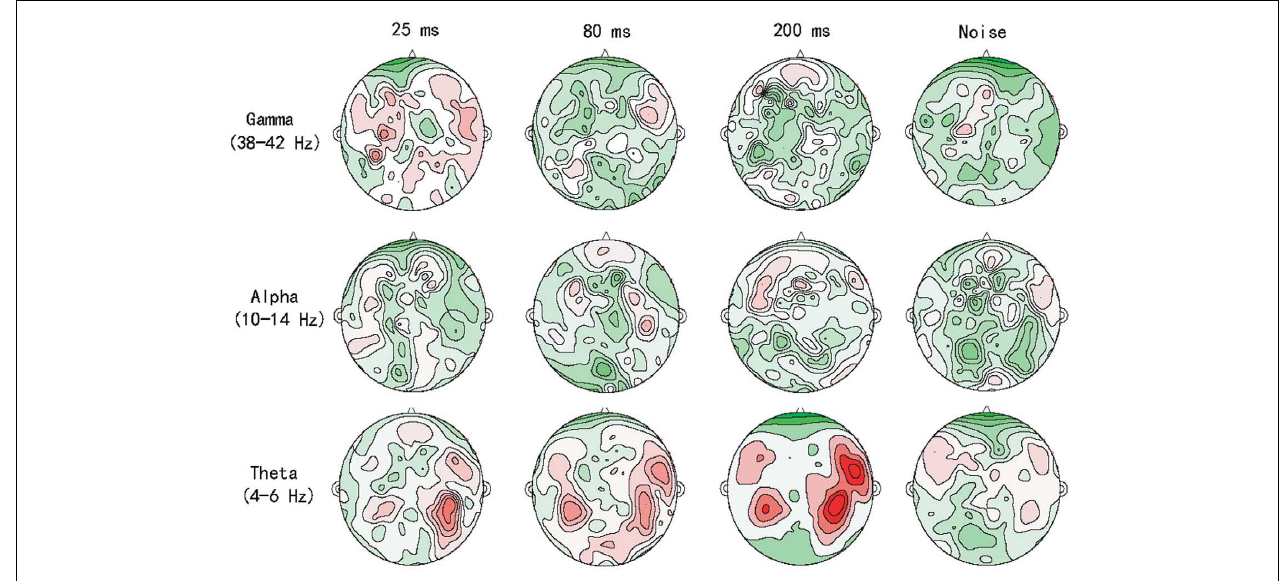
0.03 to 0.07 (green to red). Note that for gamma and theta bands (upper and lower rows), the ∼ 25 and the ∼ 200ms stimuli respectively elicited strongest phase coherence among all four stimulus conditions, whereas for the alpha band (middle row), the ∼ 80ms stimulus shows no notable